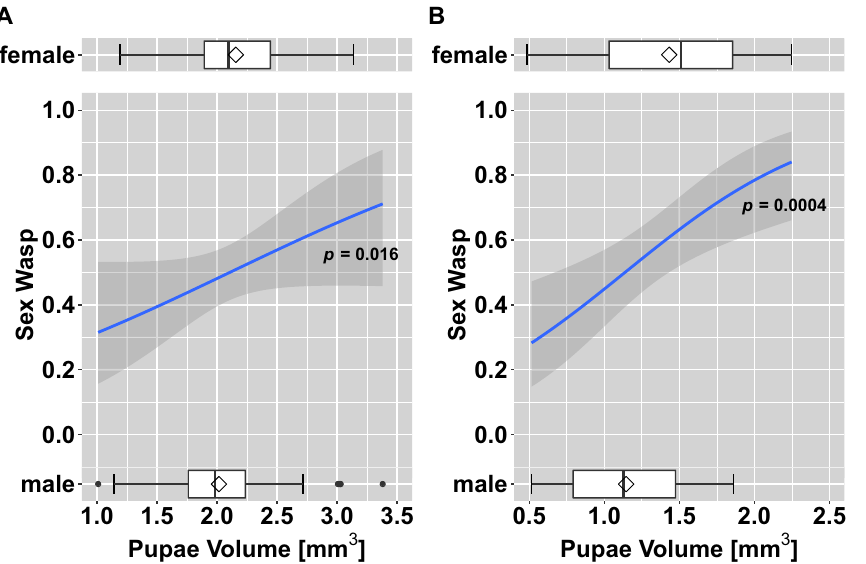
Figure 6. Sex of emerged T. drosophilae from a no choice test situation depending on the host pupal volume of A: D. suzukii and B: D. melanogaster . Boxplots give the variation in size for the pupae from which male and female wasps emerged. The curve is an estimated proportion of the sex as a function of pupal volume with a 95% confidence interval (binomial GLMM, Table S3).